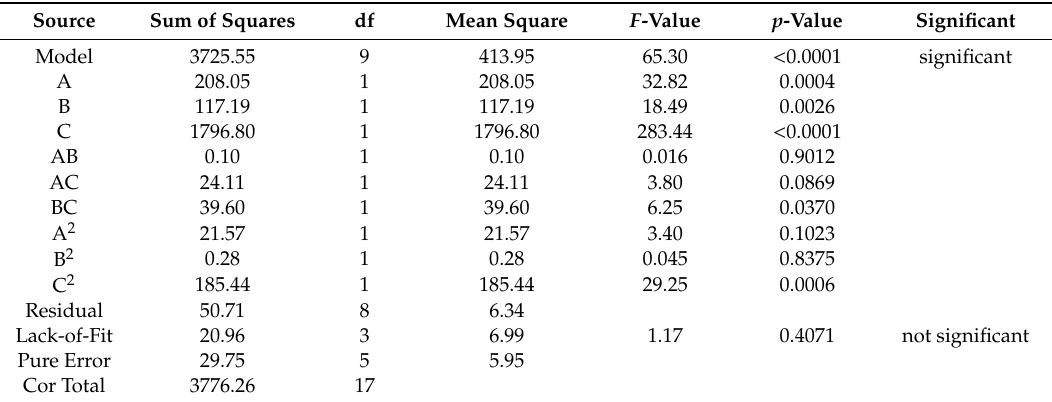
Table 3. Analysis of variance (ANOVA) results for the e ff ect of the three